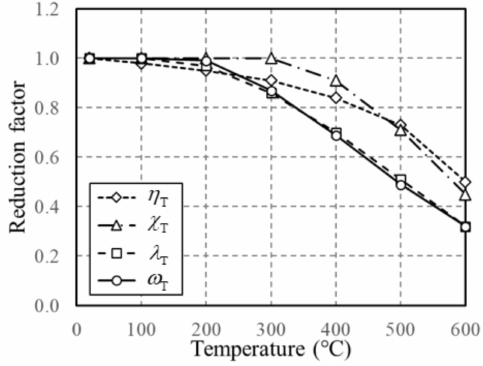
Figure 6. Reduction factors for steel and high-strength bolts at elevated temperatures. Table 1. Reduction factors for the yield strength and Young’s modulus of steel and high-strength bolts. T ( ◦